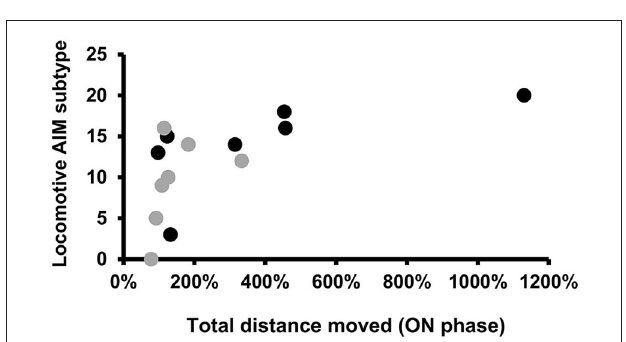
FIGURE 5 | Spearman’s correlation . Scatter plots for locomotive AIM subtype, rated on the18th day of L-DOPA treatment, plotted against the total distance moved (expressed in % values) during the ON phase. The graphs represent individual data points for all animals of the PD groups receiving L-DOPA treatment at doses of 8 mg and 6 mg. A significant positive correlation was found only in the PD + L-DOPA 8 mg group. (Spearman’s coefficient: r = 0.786, p <